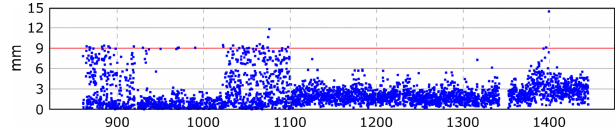
Figure 7. Long-term up component repeatability of the final coor- dinates for all stations. The site coordinate repeatability is used as an internal quality metric. Stations are sorted by name.